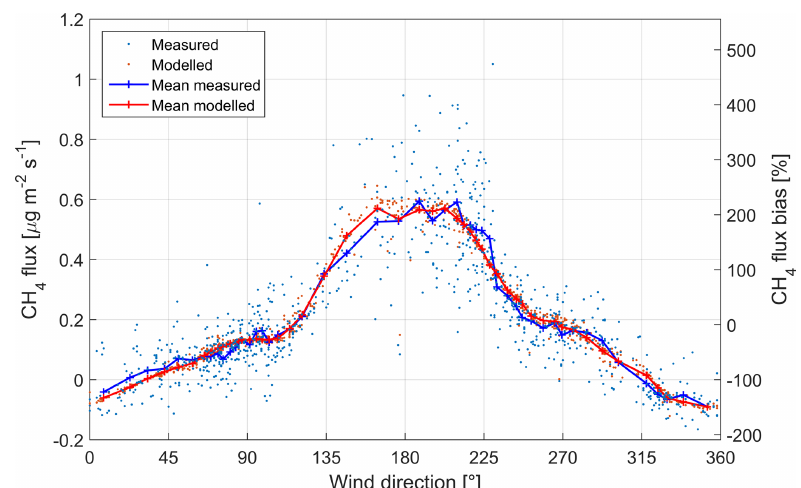
Figure 5. Measured and modelled CH 4 fluxes as a function of wind direction (left axis). The averaged data were calculated in 50 direction classes. The right axis indicates the sensor location bias of the measured data shown (both individual points and the mean) with respect to the mean upscaled flux within the study area (0.183µgCH 4 m − 2 s − 1